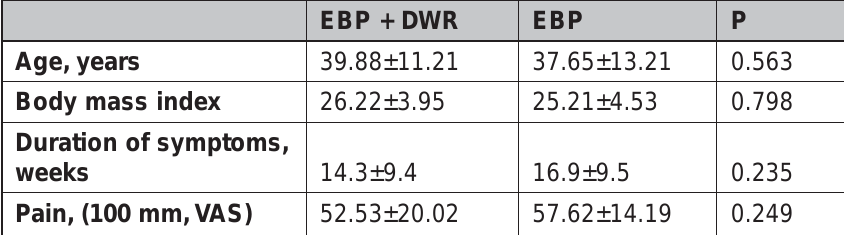
Table 1. Comparison between groups at the start of the test.